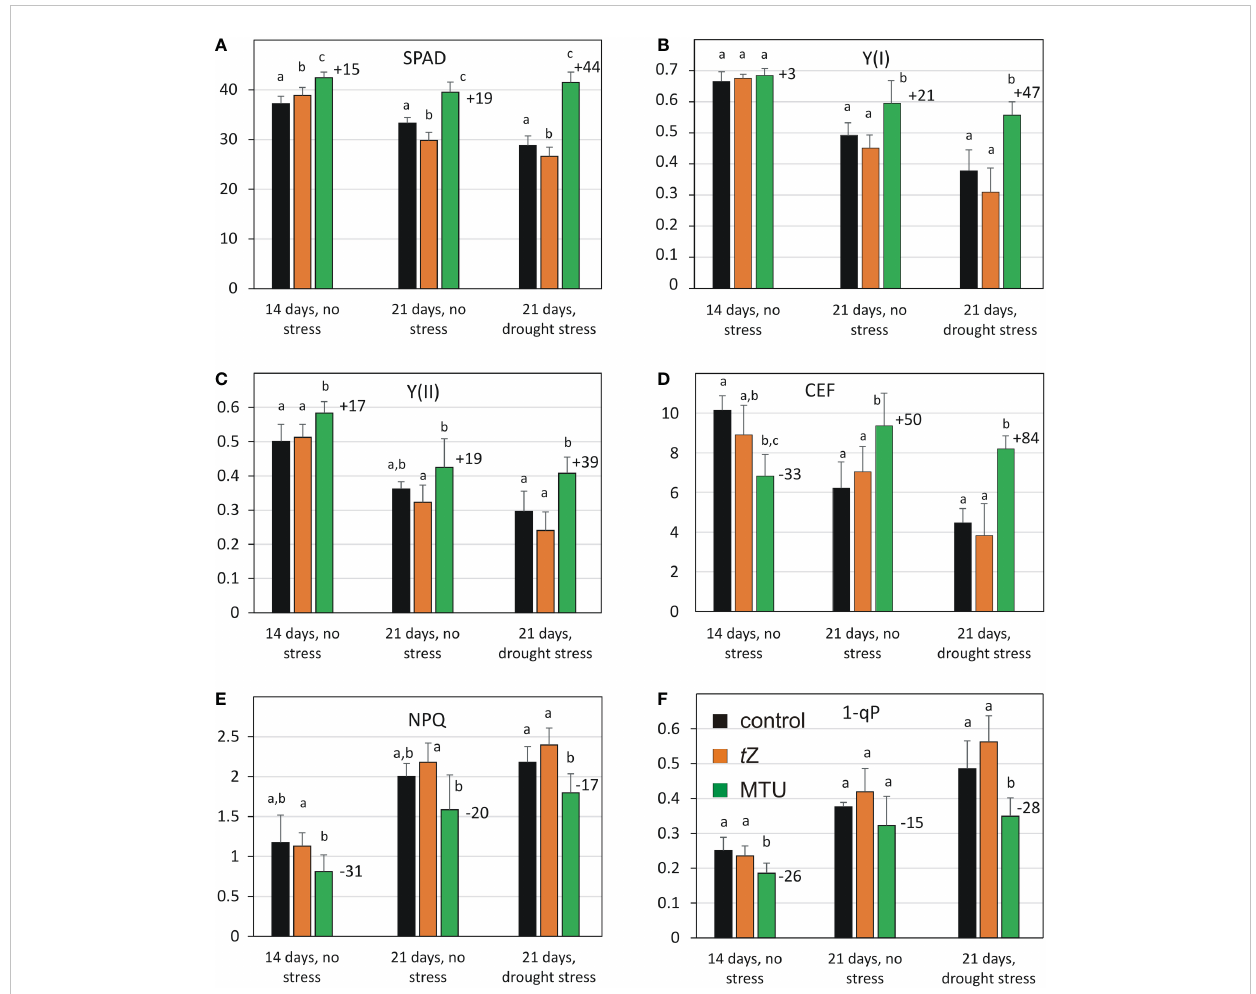
FIGURE 3 Comparison of chlorophyll content (A) and photosynthetic parameters (B-F) of wheat during age-related and drought-induced senescence (after 7 days of drought, SRWC 50%). The parameters of untreated plants were compared to those treated with trans -zeatin ( t Z) or 1-(2-methoxy-ethyl)- 3-1,2,3-thiadiazol-5-yl urea (MTU). Values are means ± SD of 5 biological replicates. Different letters indicate statistically signi fi cant differences at P < 0.05 based on the two ‐ tailed Student ’ s t ‐ test. The numbers above the columns show the percentage change in the parameter of MTU-treated plants relative to untreated control. Legend in 3F applies to all Figures. The number of days below the columns indicates the age of the plants. SPAD – relative chlorophyll content analyzed by Soil Plant Analysis Development (SPAD) chlorophyll meter; Y(I), Y(II) – effective quantum yields of PSI and PSII, respectively; CEF, cyclic electron fl ow; NPQ, non-photochemical quenching; 1-qP – a fraction of reduced PQ